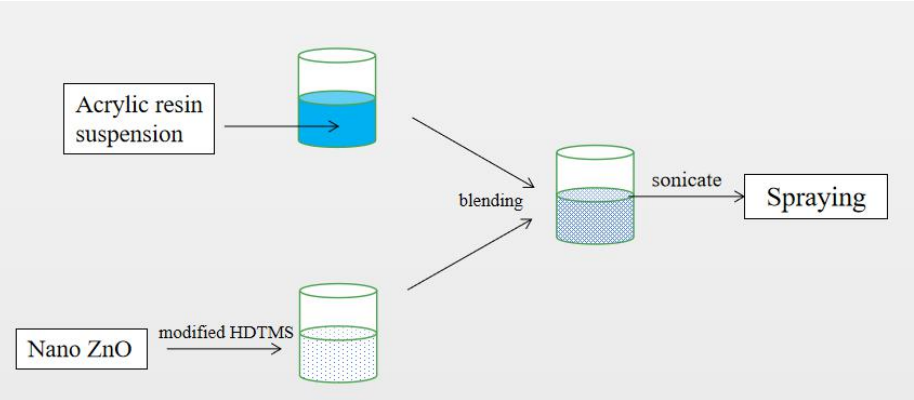
Figure 1. Flow chart of preparation of superhydrophobic coating of acrylic resin via the blending